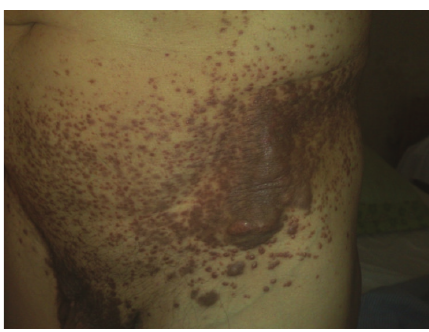
Figure 8: Foam cells were also